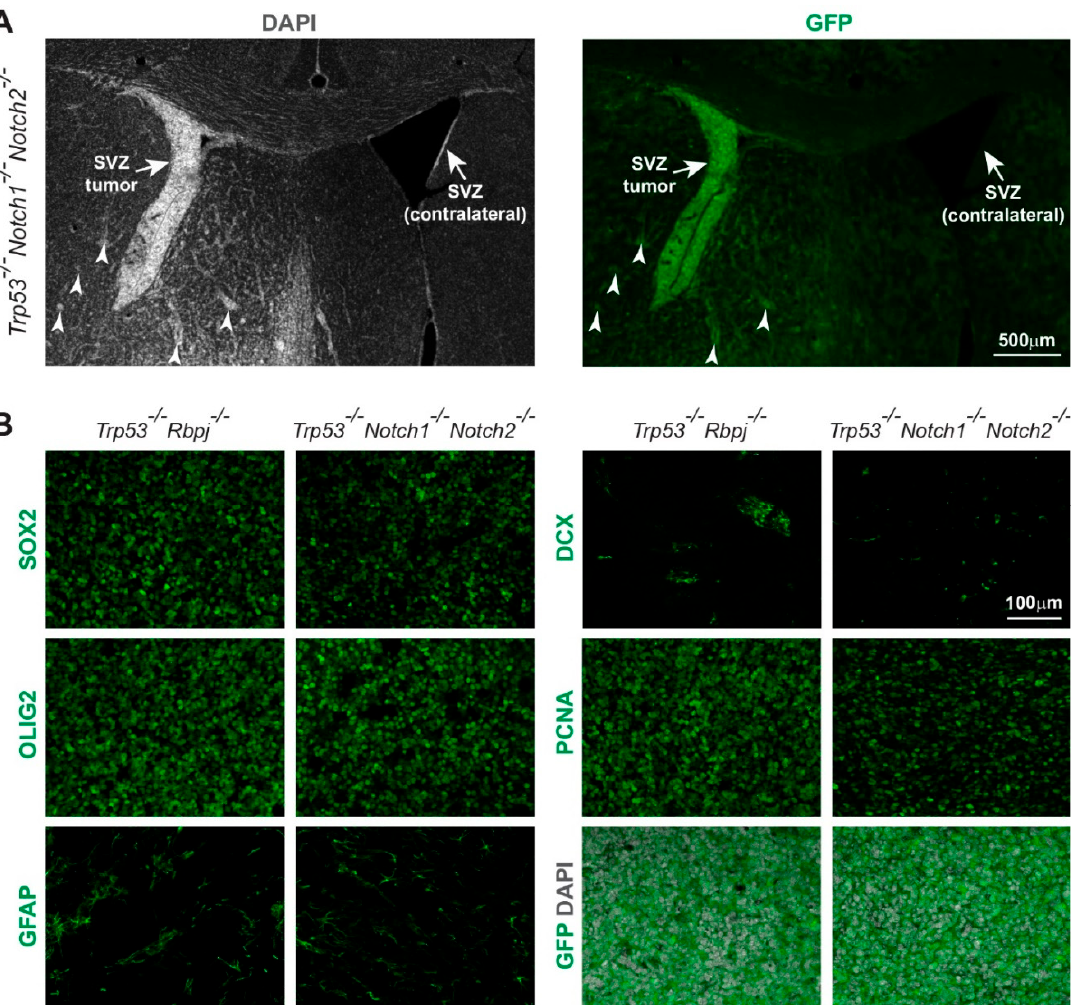
Figure 2. Immunohistochemical analysis of Trp53 ‐ / ‐ Notch1 ‐ / ‐ Notch2 ‐ / ‐ and Trp53 ‐ / ‐ Rbpj ‐ / ‐ tumors. ( A ) A Trp53 ‐ / ‐ Notch1 ‐ / ‐ Notch2 ‐ / ‐ tumor in the SVZ. Streams of tumor cells invading the brain parenchyma are indicated by arrowheads. The GFP expression from the Rosa ‐ CAG::GFP Cre ‐ reporter indicates derivation from Hes5 + cells. ( B ) Expression of GFP, progenitor (SOX2) and glial markers (OLIG2, GFAP), as well as staining for mitotically active cells (PCNA) and immature neurons (DCX) in Trp53 ‐ / ‐ Notch1 ‐ / ‐ Notch2 ‐ / ‐ and Trp53 ‐ / ‐ Rbpj ‐ / ‐ tumors.